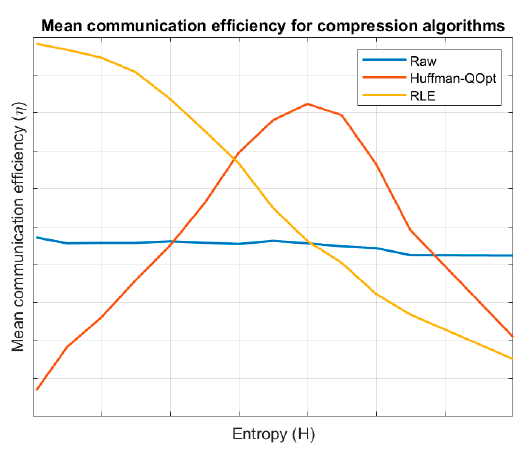
Figure 6. Mean communication efficiency for different compression algorithms.